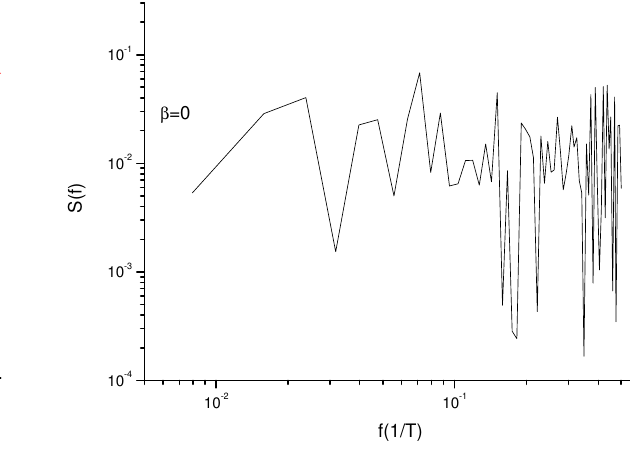
Fig. 5. Power spectrum of the increment time series for the rate shown in Fig. 4a.